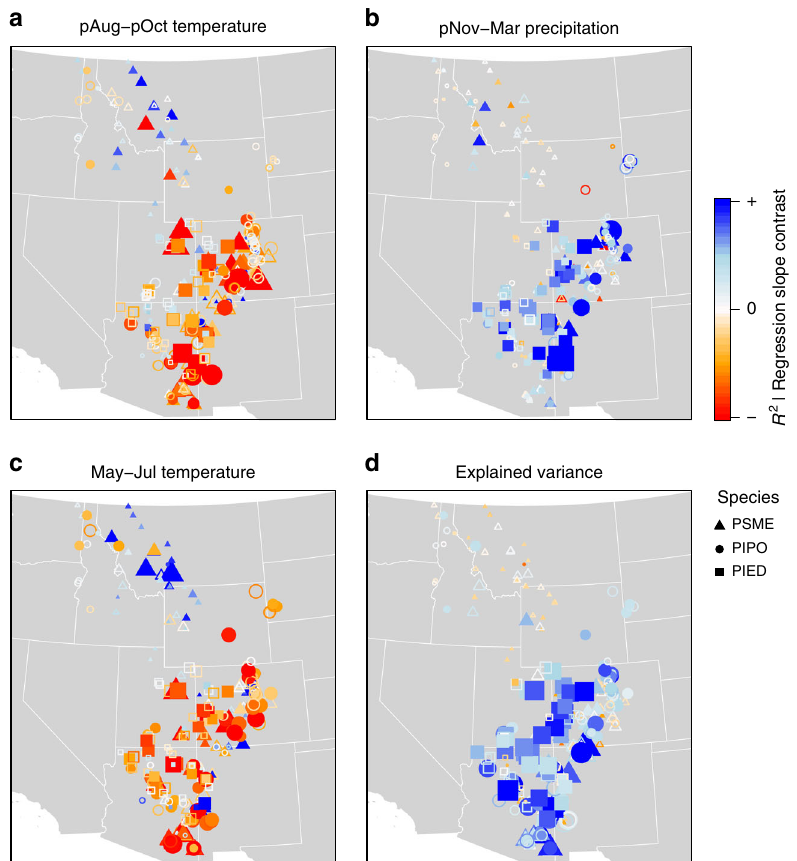
Fig. 4 Comparison of median climate sensitivity and explained variance of targeted (ITRDB) vs. forest inventory (FIA) samples. Symbol size indicates the absolute magnitude of a − c sensitivity to three climate variables (regression slopes) and d explained variance ( R 2 ) of ITRDB samples, with positive contrasts (ITRDB minus FIA) in blue, and negative contrasts in orange to red. Filled symbols denote signi fi cant differences at p < 0.01 (two-sided Wilcoxon test) of the FIA distribution surrounding each ITRDB site. R 2 contrast values range from − 0.30 to + 0.41, while slope contrasts range from − 0.18 to + 0.23 (temperature) and − 0.03 to + 0.06